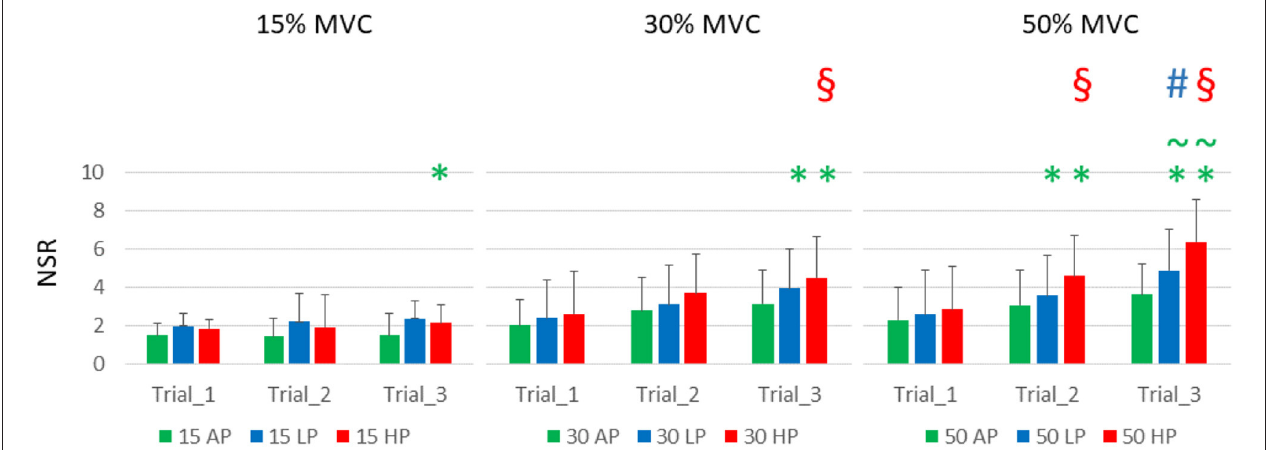
FIGURE 3 | Subjects’ reported discomfort. NSR is displayed as average and standard deviation across all the subjects for each condition and trial. It is possible to notice that the torque level had a relatively smaller effect on discomfort compared to the continuous application of blood flow restriction either partial (LP) or complete (HP). HP was responsible for the highest discomfort scores over time. It is important to notice that 4 subjects did not complete the last trial at 50%MVC HP, and they were asked to rate their discomfort at failure. Green asterisks (* ) indicate statistical significance against AP1 for the same level of torque, green tilde ( ~ ) indicates significance against AP3, red section sign ( § ) against HP1, and the blue hash sign ( # ) against LP1 for and alpha level of 0.025).